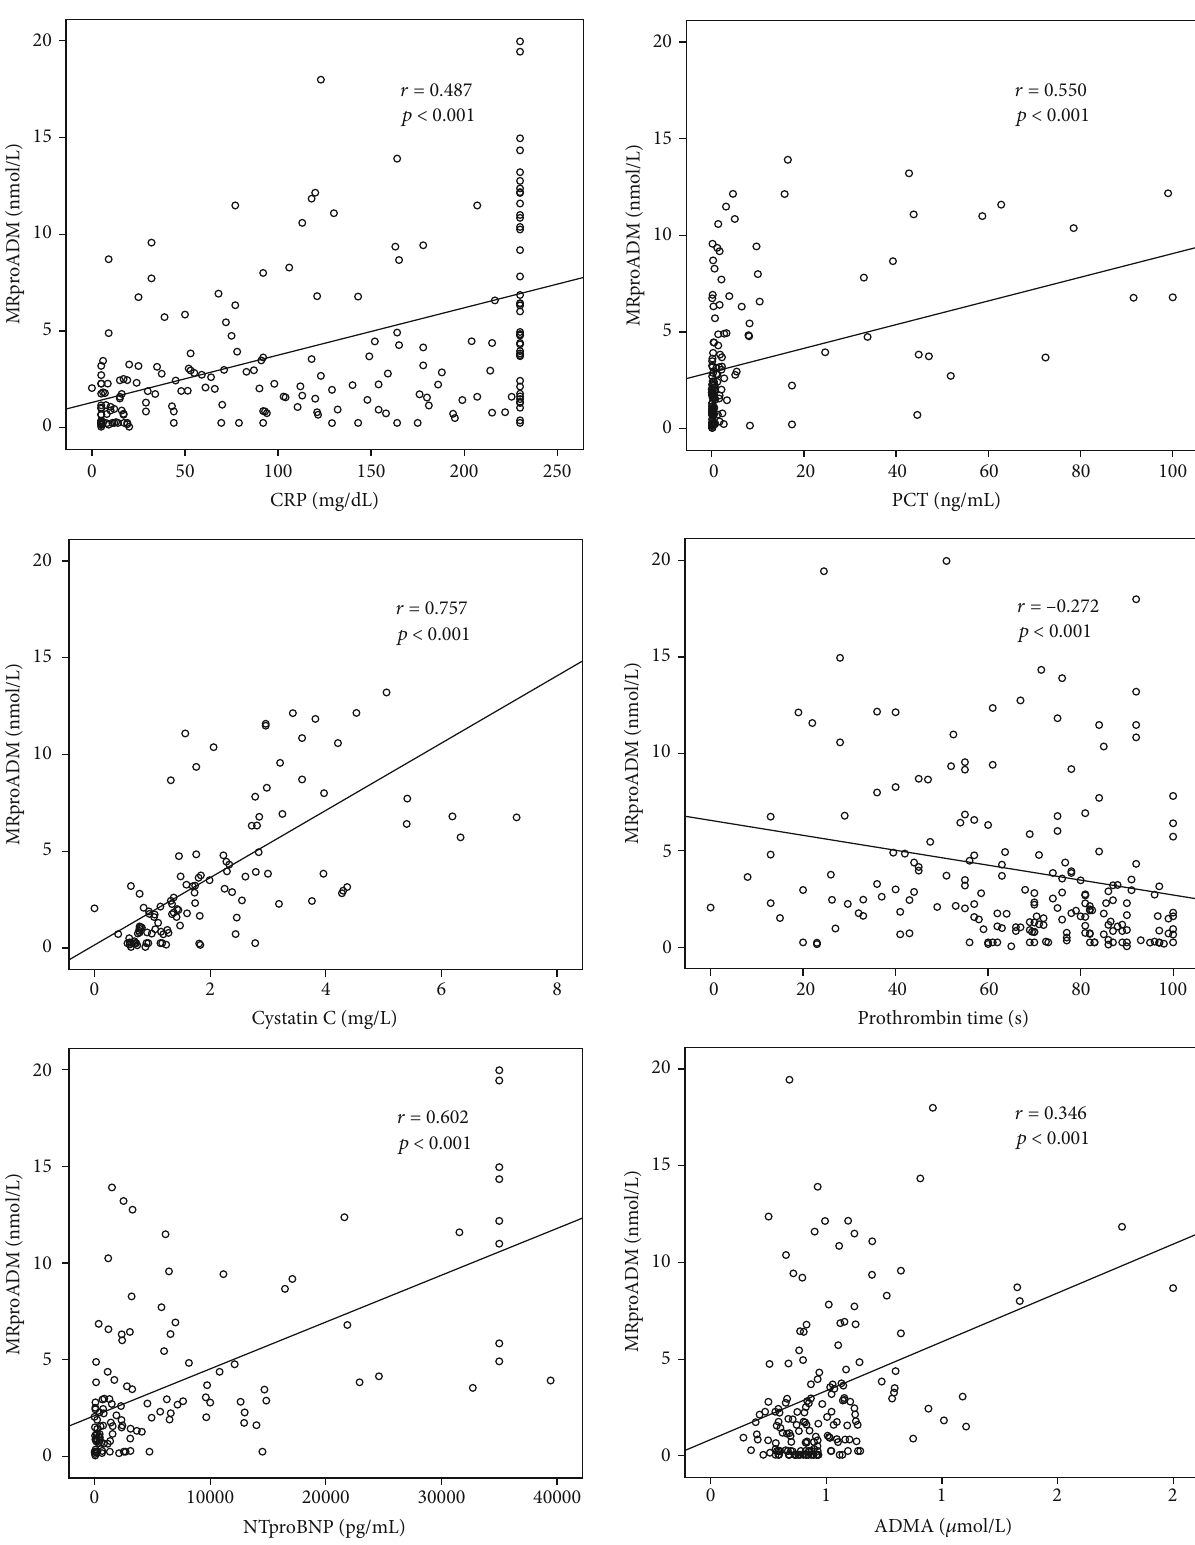
Figure 2: Serum MRproADM levels in critically ill patients correlate with in fl ammation and organ failure. Correlation analyses revealed associations between serum MRproADM and biomarkers of systemic in fl ammation (e.g., CRP), renal failure (e.g., cystatin), hepatic dysfunction (e.g., prothrombin time), cardiac failure (e.g., NT-proBNP), or endothelial dysregulation (e.g.,